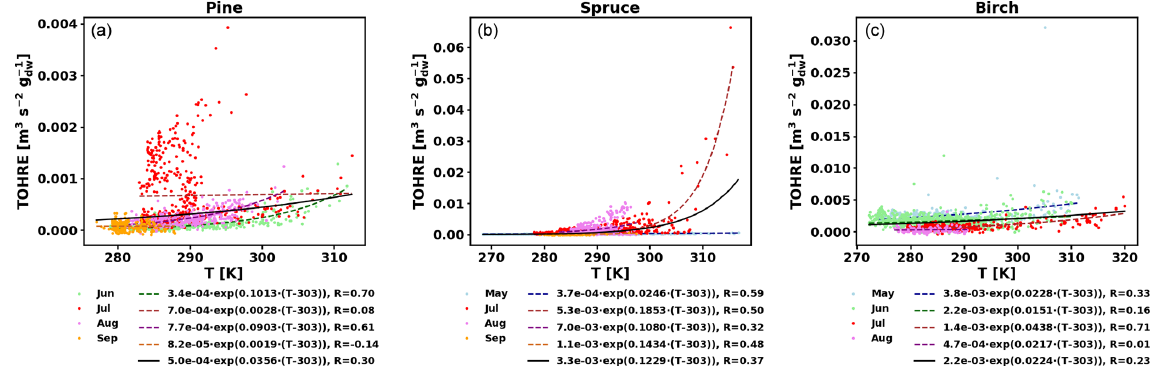
Figure 5. TOHRE as a function of temperature in the branch enclosure for pine (a) , spruce (b) , and birch (c) . Coloured dots and dashed lines are data separated by month (data and exponential regression), and the solid black line is the exponential regression for all data. Table 2. Regression coefficients (TOHRE S and β ) for the exponential regressions of TOHRE as a function of temperature and regression coefficients (TOHRE 0 , pool , β , and TOHRE 0 , synth ) for its dependence on both temperature and light using the hybrid algorithm, as well as coefficients of correlation ( R